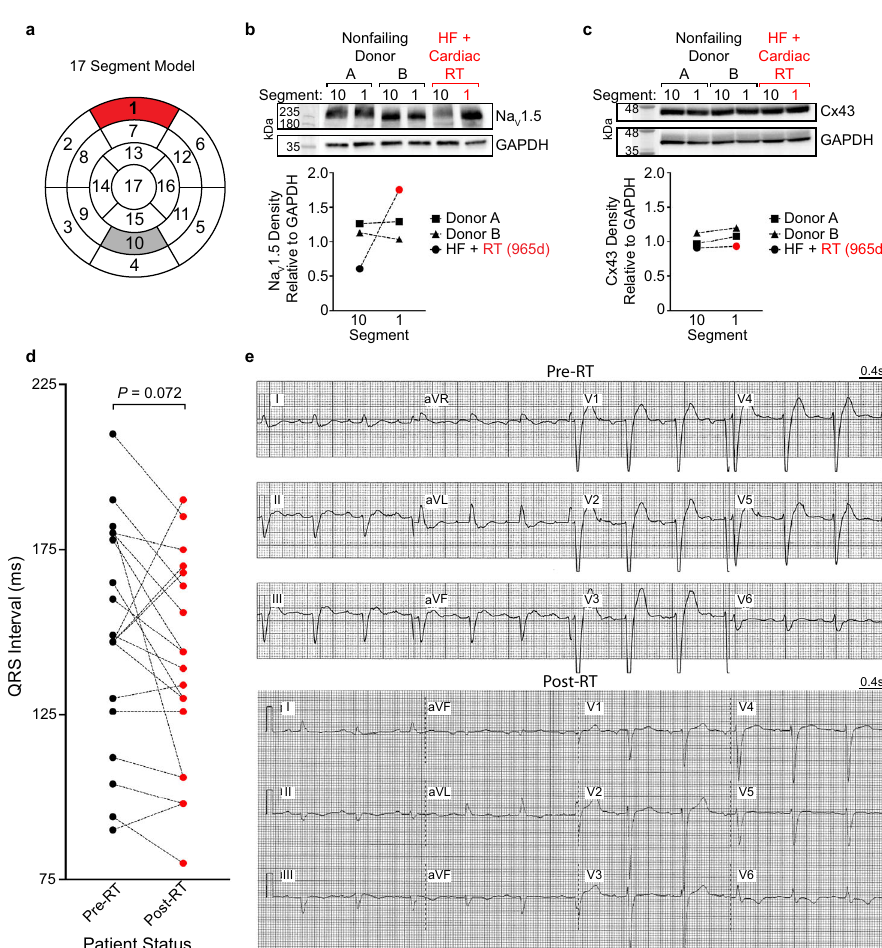
Fig. 8 Reprogramming in VT patients treated with 25 Gy RT. a Cardiac 17-segment model illustrating 25 Gy targeted (Segment 1, red) and remote nontargeted (Segment 10, gray) myocardium collected from a heart failure patient with nonischemic cardiomyopathy and VT (Patient F), who previously received cardiac RT. The nontargeted Segment 10 received <5 Gy radiation exposure. For comparison, corresponding Segments 1 and 10 were collected from 2 nonfailing, non-RT donor hearts rejected for transplantation. b Western blot and quanti fi ed densitometry of Na V 1.5 in Segment 10 versus Segment 1 of nonfailing (Donors A and B) and RT-treated (HF + Cardiac RT, red) hearts. c Western blot and quanti fi ed densitometry of Cx43 in Segment 10 versus Segment 1 of nonfailing and RT-treated hearts. d Matched QRS durations in the ENCORE-VT patient cohort at baseline (pre-RT, 149 ± 34 ms) versus 6-week post-RT (139 ± 32 ms) timepoints ( n = 19 paired individual patients, P = 0.072 by two-tailed Wilcoxon signed-rank test). e Representative 12-lead ECG of robust QRS shortening recorded from Patient G at the time of RT treatment, with a baseline QRS of 165 ms and presence of LBBB, and then after 6 months post-RT, exhibiting shortened QRS (130 ms) and resolution of LBBB. Examples of pre- and post-RT ECGs of the remaining three patients that exhibited robust QRS shortening in the ENCORE-VT patient cohort, as well as an example of an unchanged QRS interval, are provided in the Supplementary Figures. Source data are provided as a Source data fi